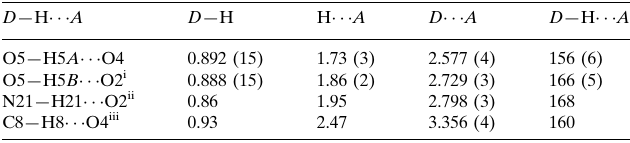
Hydrogen-bond geometry (A˚ , (cid:2)